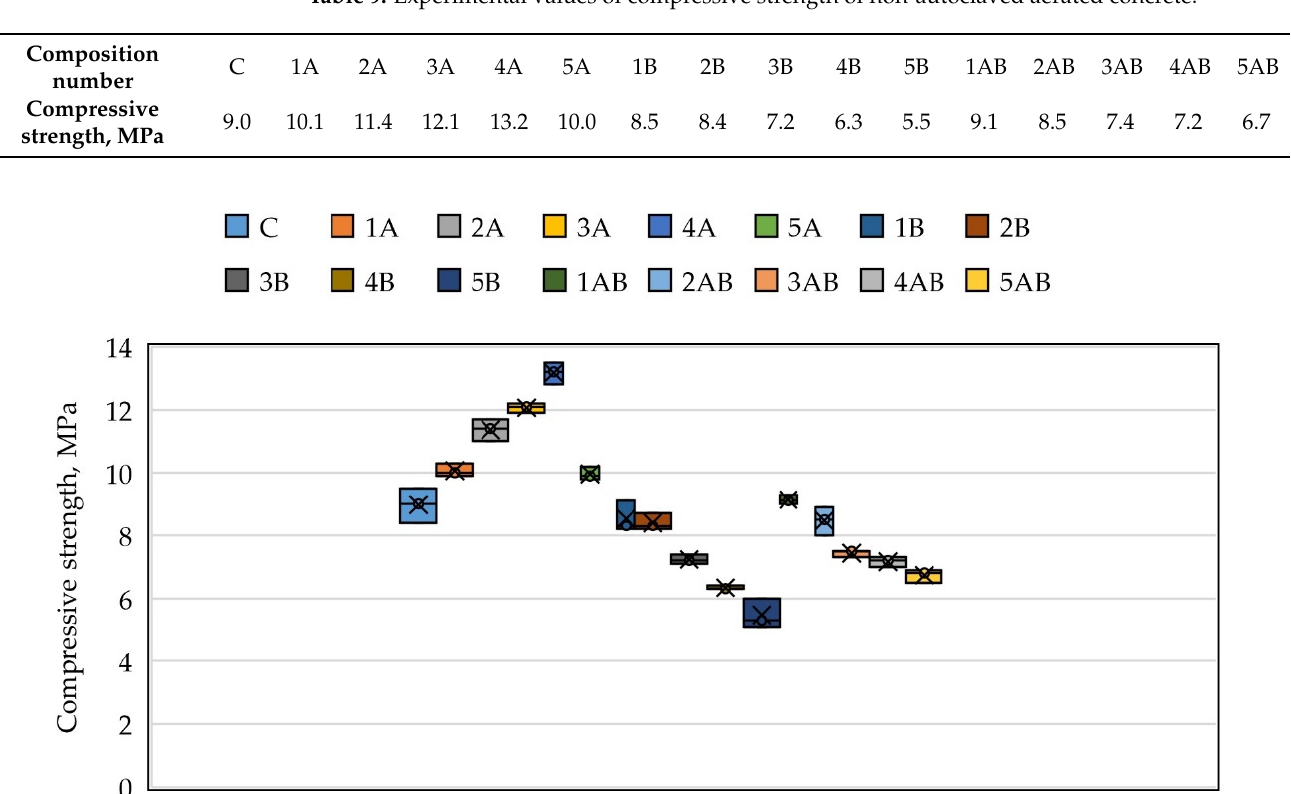
Table 9. Experimental values of compressive strength of non-autoclaved aerated concrete.